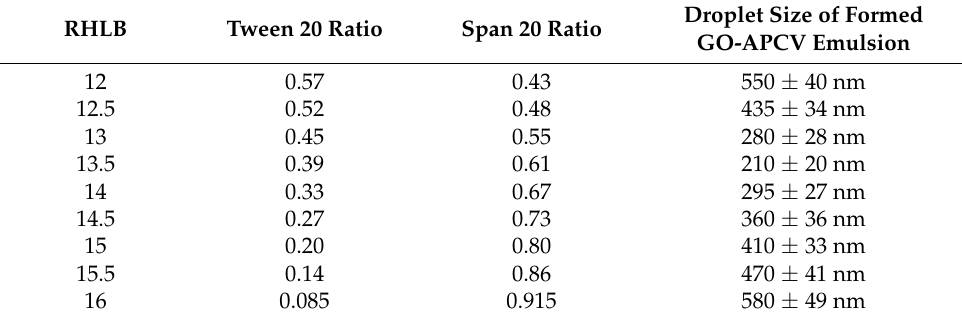
Table 2. RHLB and droplet sizes of GO-APCV emulsions formulated using different Tween 20/Span 20